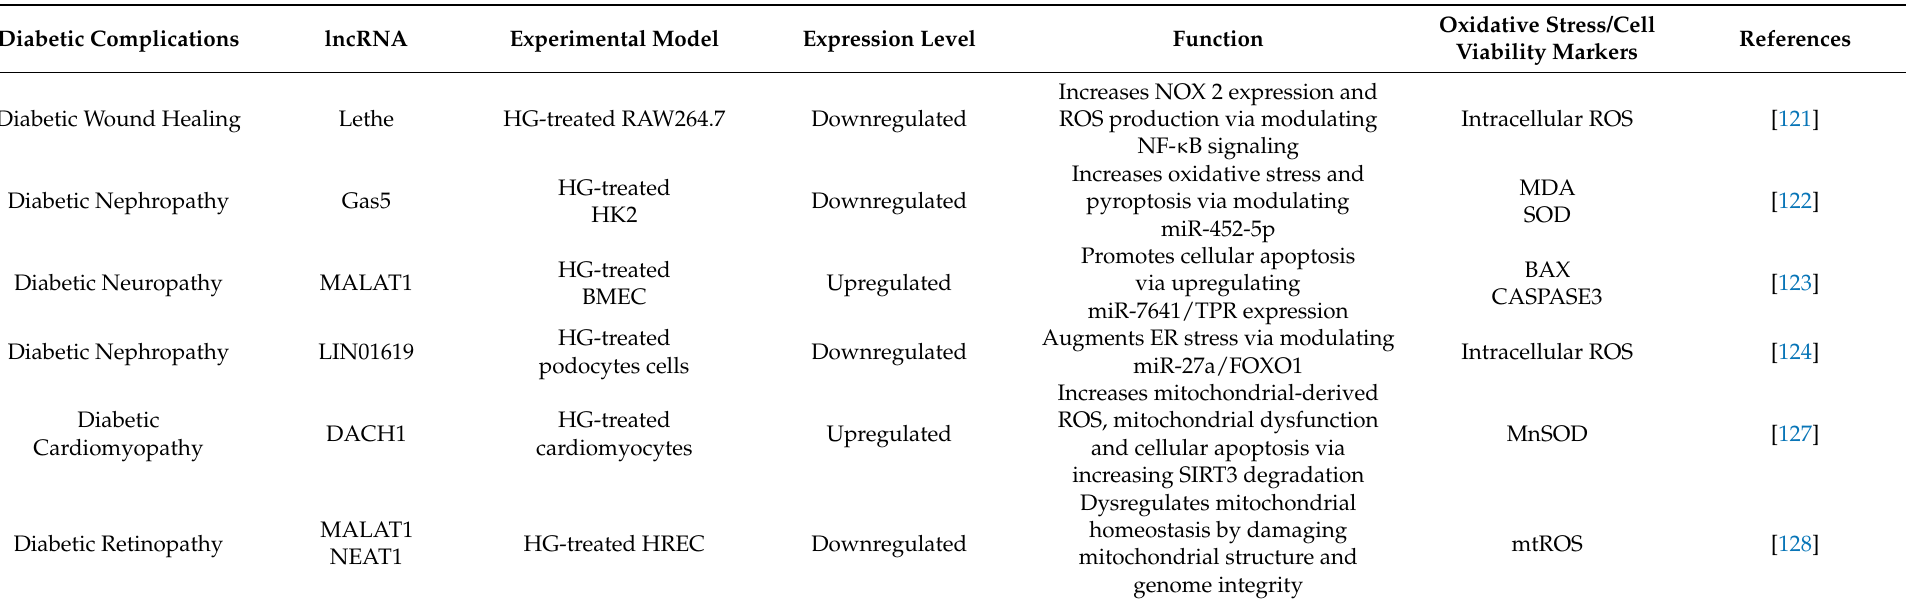
Table 2. lncRNAs and the mechanisms associated with oxidative stress and mitochondrial function in diabetic